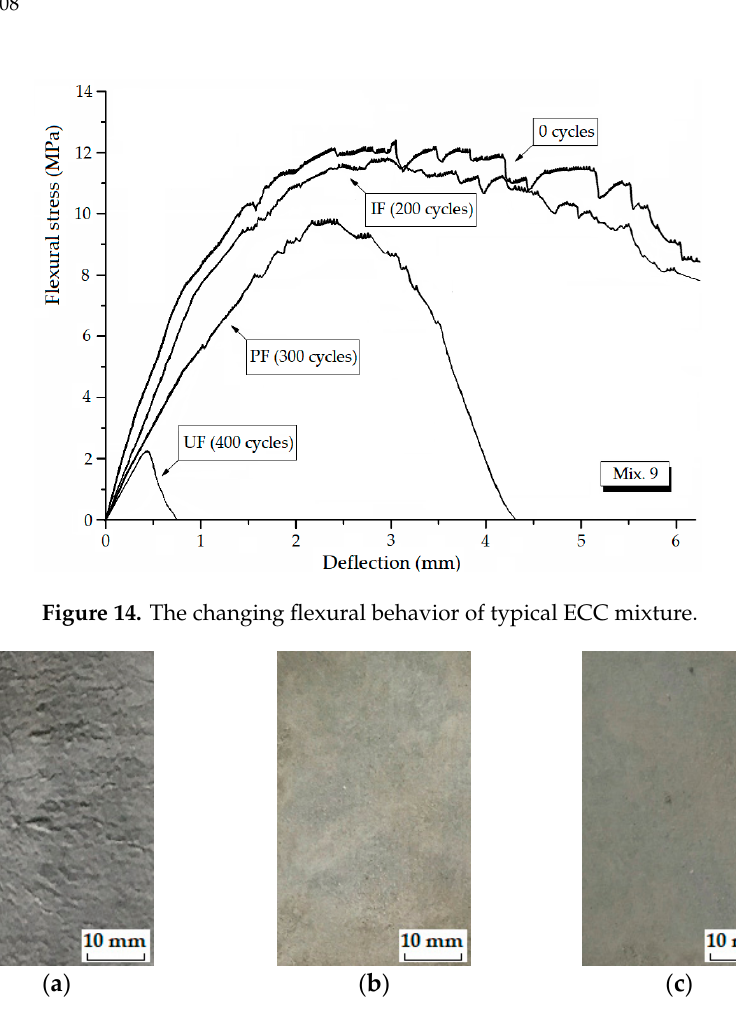
Figure 15. The surface appearance of typical ECC mixtures: ( a ) Mix. 6 after 75 cycles; ( b ) Mix. 4 after 350 cycles; ( c ) Mix. 9 after 400 cycles.